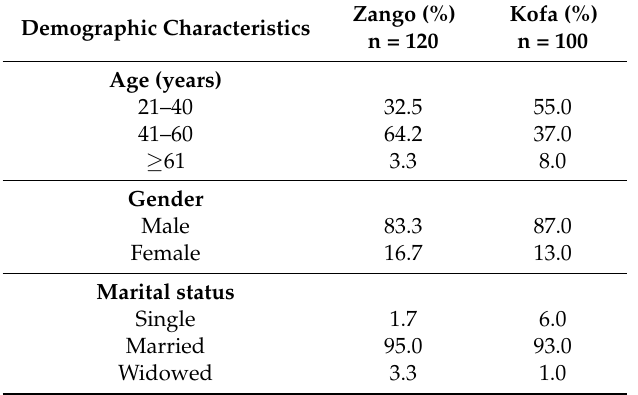
Table 3. Demographic characteristics of Zango and Kofa